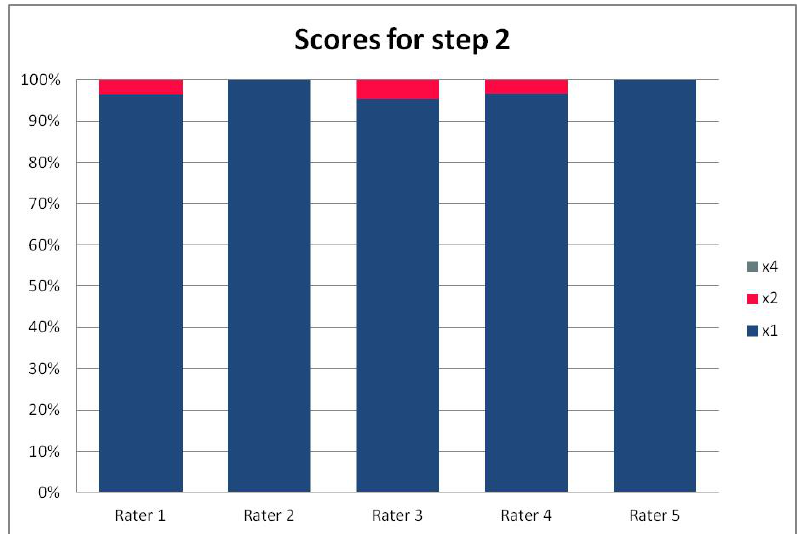
Figure 3. The percentage of ratings in the available categories given by individual raters for step 2 of the PRAETORIAN score.